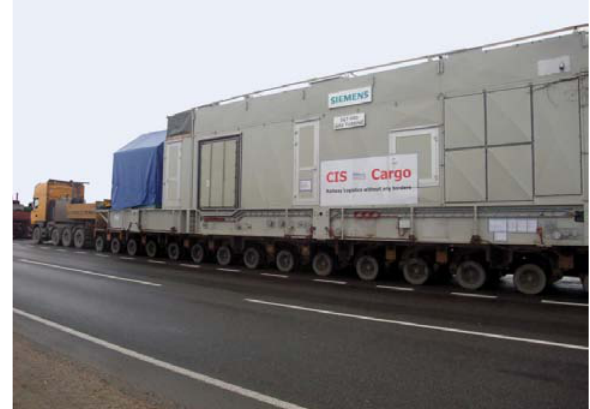
Fig. 1. Extraordinary